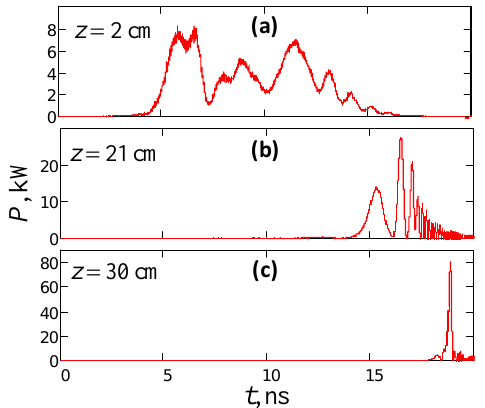
Fig. 2 . Evolution of the radiated pulse in the section of